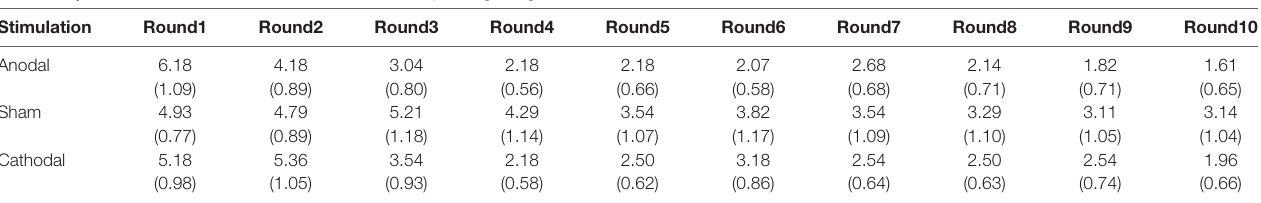
TABLE 1 | Means and SE of the data for contributions in public good games under three conditions. Stimulation Round1 Round2 Round3 Round4 Round5 Round6 Anodal